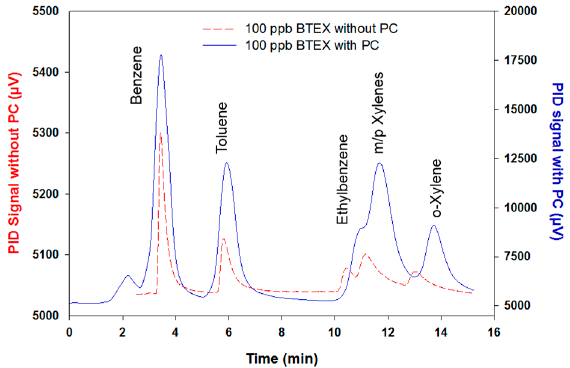
Figure 8. Red dashed line: Chromatogram of 100 ppb BTEX without preconcentration step (sample volume of 200 µ L). Blue solid line: Chromatogram of 100 ppb BTEX with preconcentration step (sample volume of 20